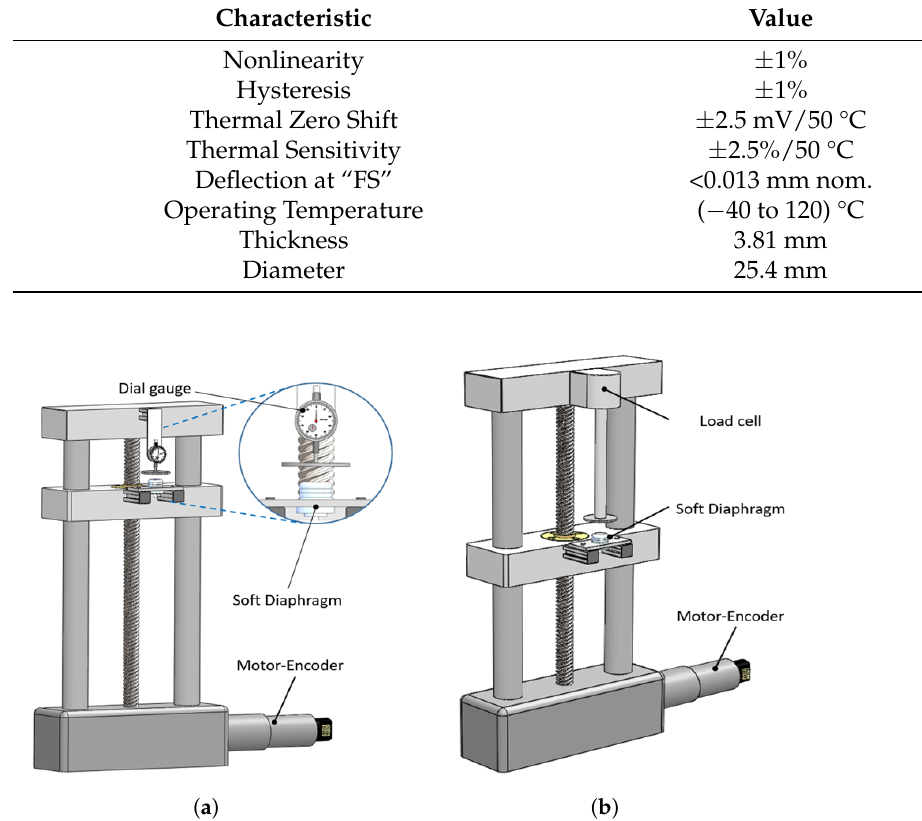
Figure 11. Devices for measuring the soft actuators features. ( a ) Assembly of the dial gauge to measure the displacements in the soft diaphragm. ( b ) Assembly of the load cell to measure the contact force in the soft diaphragm.